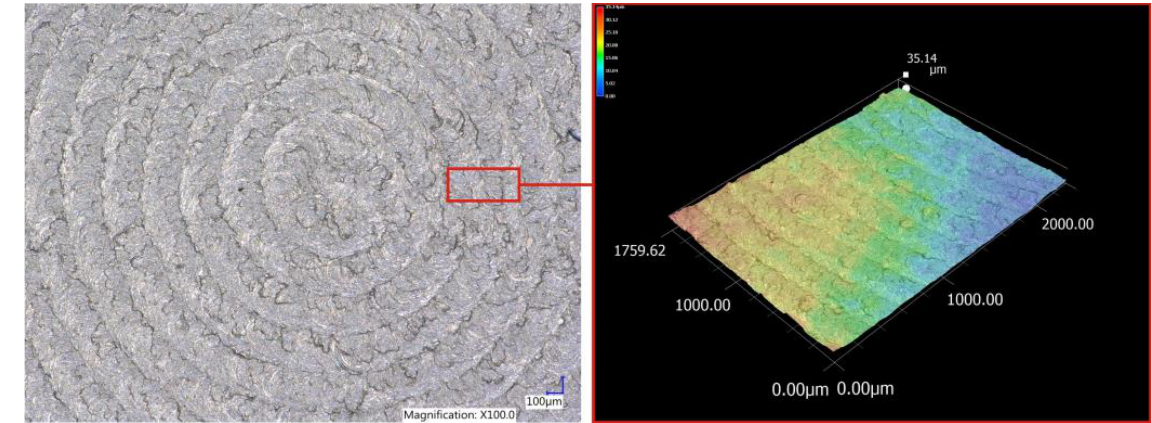
Figure 24. Display of surface texture and SH in constant Z strategy.